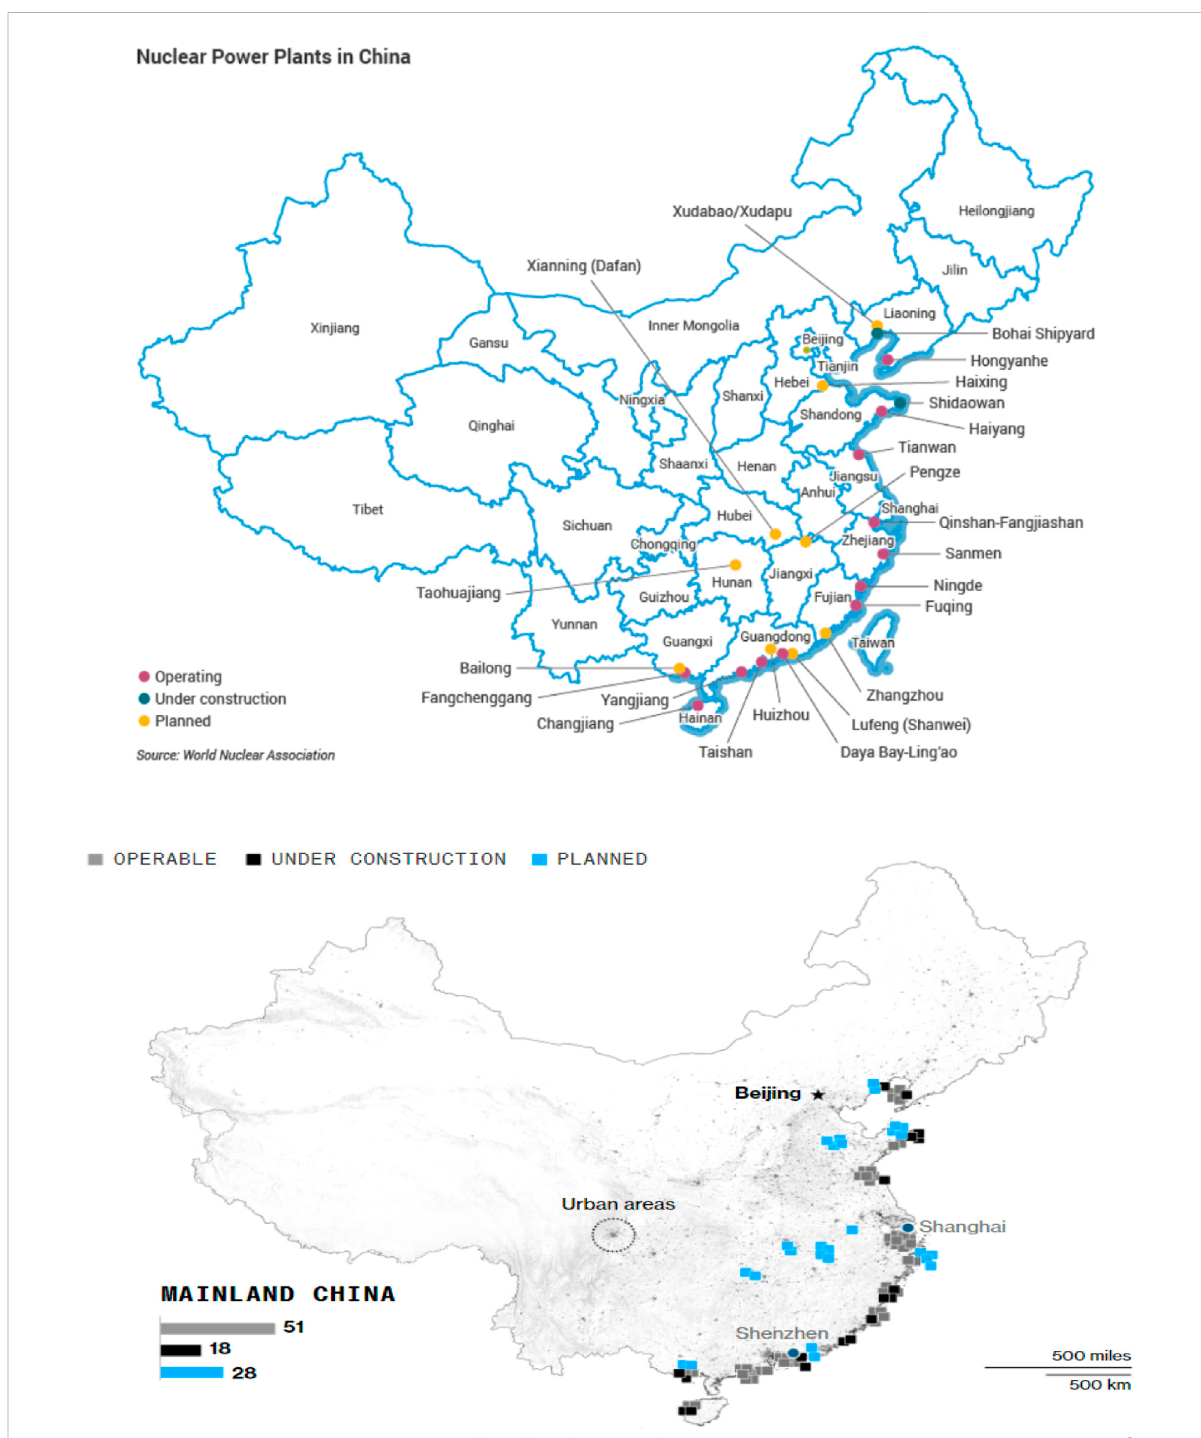
FIGURE 2 Location of planned or under-construction nuclear power plants in